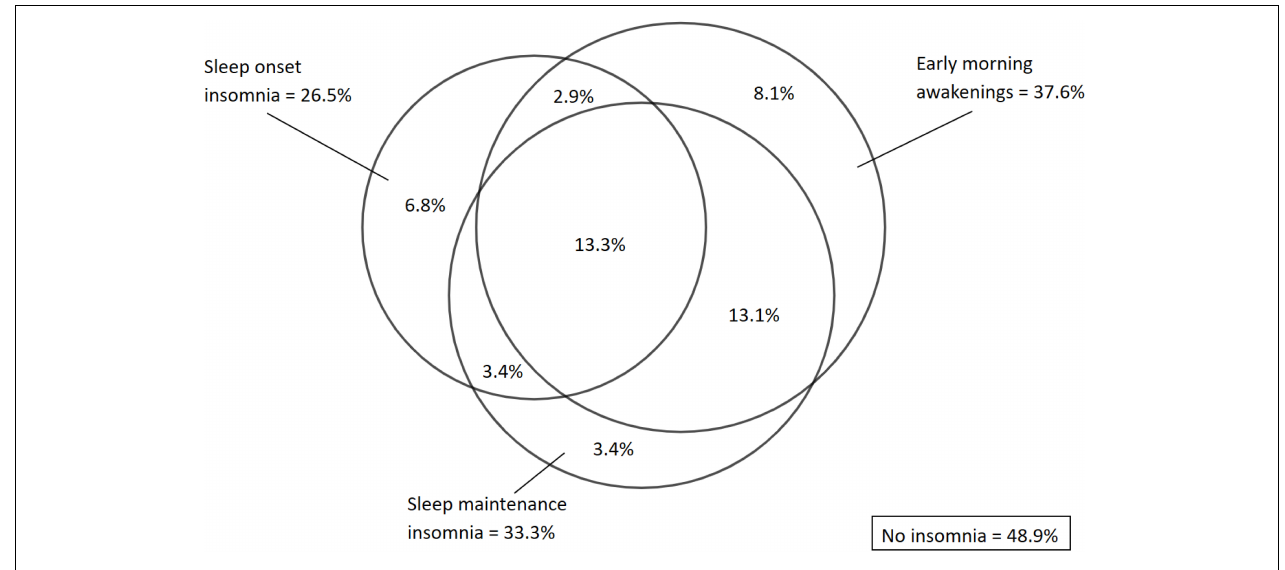
FIGURE 2 | Prevalence and overlapping between insomnia subtypes at baseline among all patients with OSA ( n = 442). TABLE 3 | Comparison of BIS scores at baseline and follow-up depending on adherence in 442 Norwegian patients with OSA treated with CPAP. Baseline BIS Follow-up BIS Mean